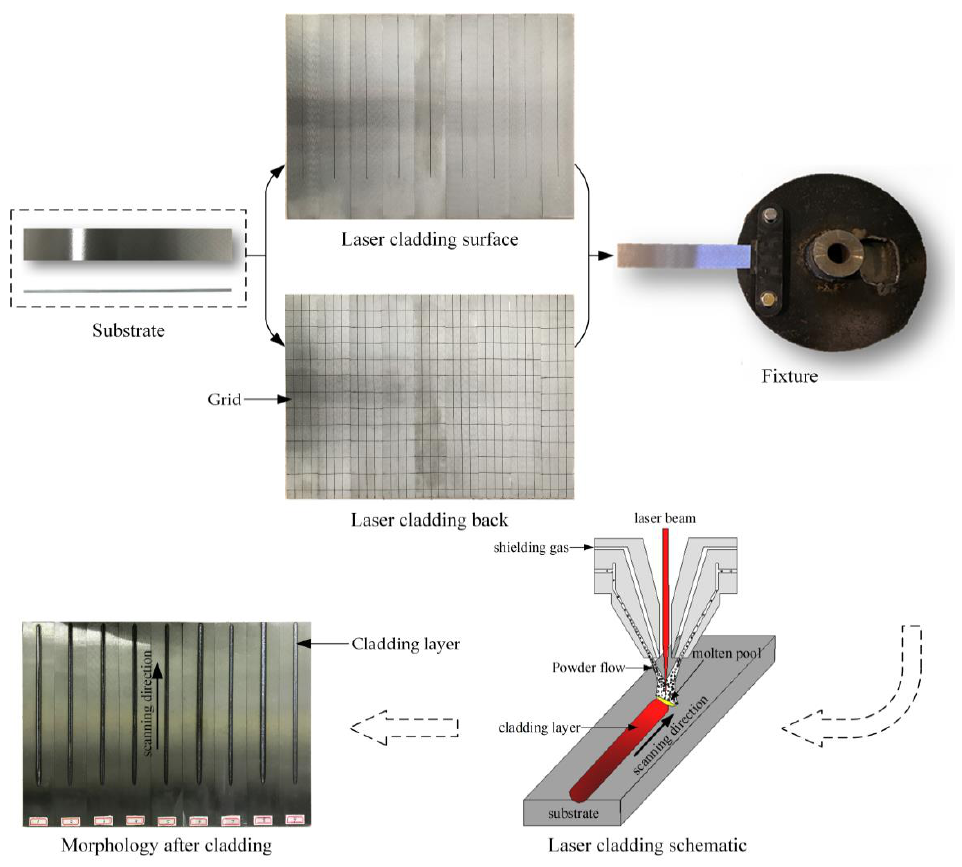
Figure 2. Laser cladding process.